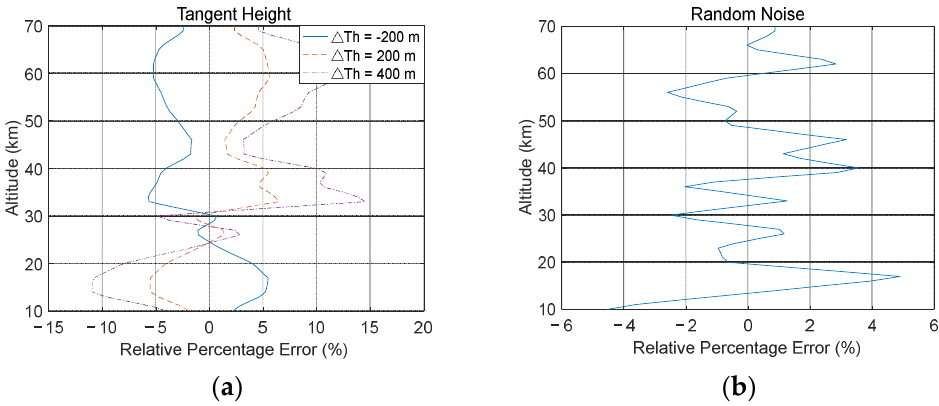
Figure 7. Relative percentage error. ( a ) Different tangent height deviations; ( b ) random noise. Noise